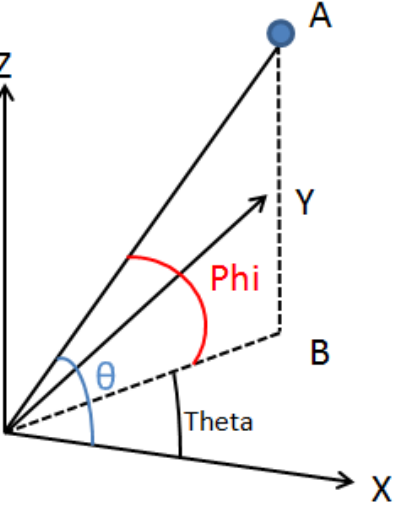
Figure 7. Schematic diagram of Avizo calculating the orientation angle of the polyester-short-fiber-reinforced rubber composite sample after binarization treatment.